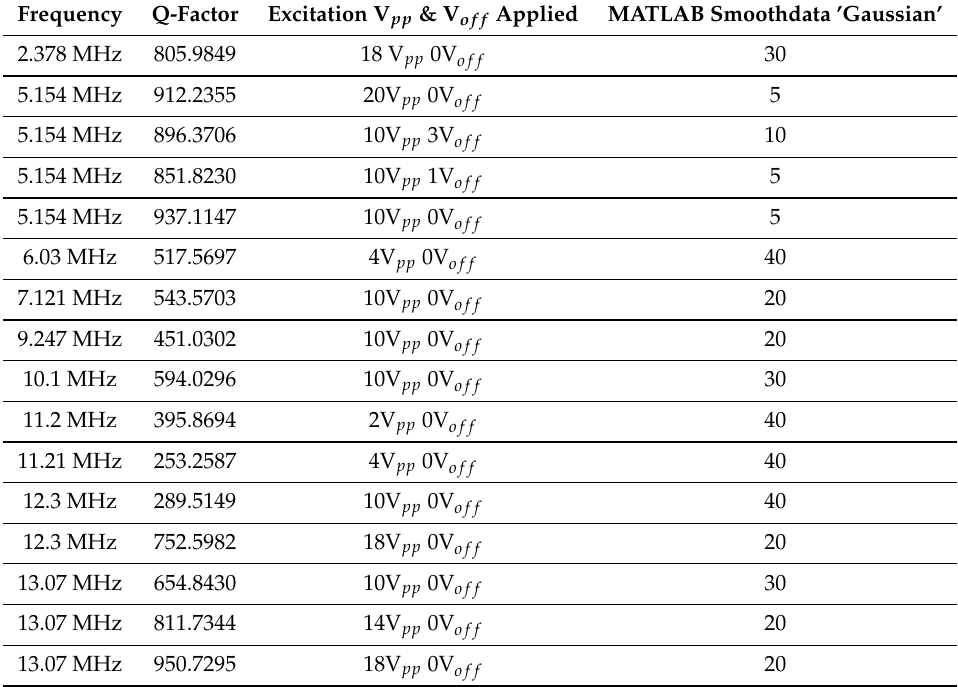
Table A1. Q-factors computed using MATLAB ’gaussian’ smoothed peaks detected in the range of 2 to 24 MHz. Frequency